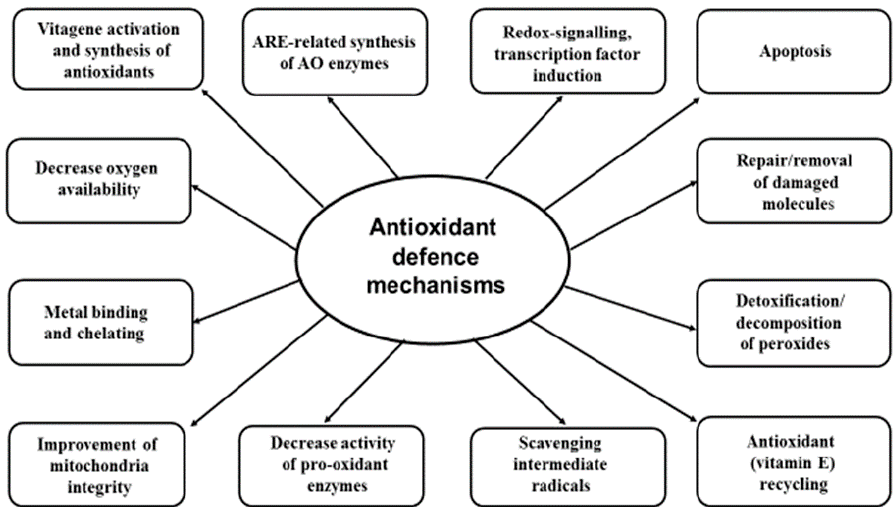
Figure 1. Antioxidant defense mechanisms in the body (Adapted from [6,30]).